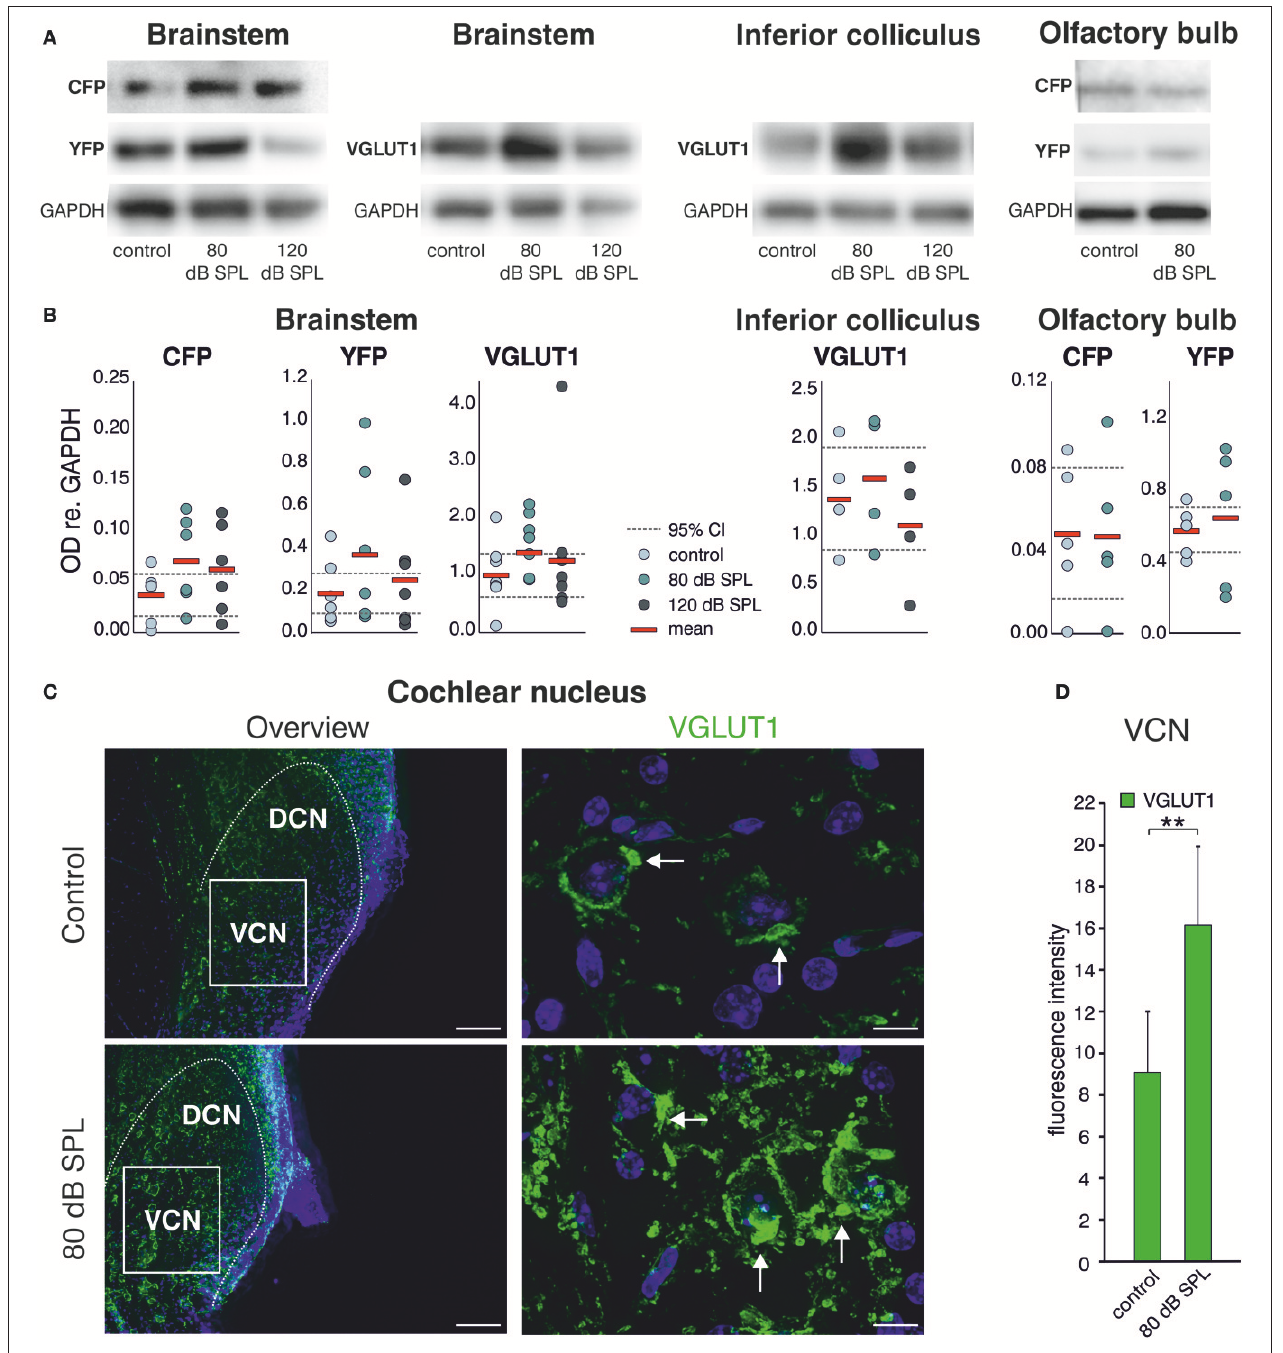
FIGURE 2 | Acoustic enrichment leads to a trend for higher expression of VGLUT1 in the brainstem and inferior colliculus together with Bdnf exon-IV-CFP and exon-VI-YFP. (A) Western blot analysis of CFP and YFP in the brainstem and olfactory bulb as well as VGLUT1 in the brainstem and inferior colliculus in homozygous BLEV reporter mice 2 weeks after exposure to either sham, 80, or 120 dB SPL. The housekeeping gene GAPDH is used for normalization between conditions. For originals see Supplementary Figures 2A–C. (B) Densitometric analyses of Western blots (dots: averaged results per animal, bars: means, dashed lines: 95% confidence interval for the controls; n = 5–6 mice/group 2–10 Western blots each). (C) VGLUT1 immunostaining (green) in cochlear nucleus mouse slices 2 weeks after exposure to sham or 80 dB SPL. After exposure to 80 dB SPL immunoreactivity (IR) for VGLUT1 is increased in the dorsal and ventral cochlear nucleus (DCN, VCN). Nuclei stained with DAPI (blue). Arrows indicate VGLUT1 localization. Scale bars: 100 µ m; 5 µ m. (D) Quantification of VGLUT1 IR in an 85 × 60 µ m frame in the VCN following sham and 80 dB SPL exposure. Data represented as mean ± SD.